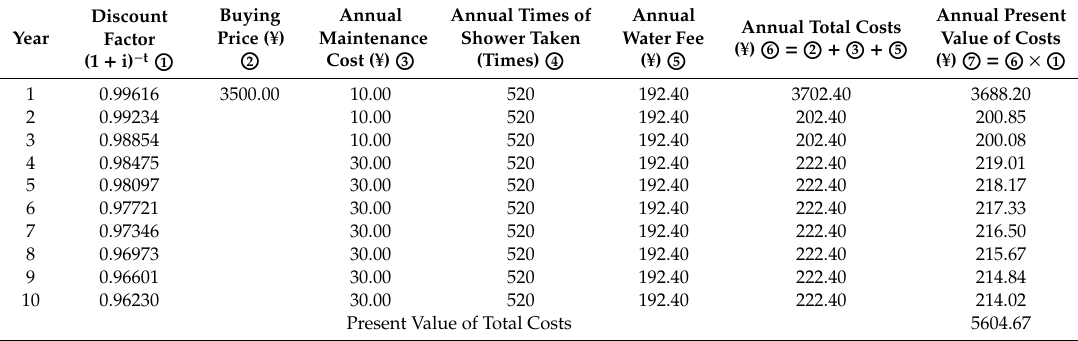
Table 6. Present value of the total costs of using a solar water